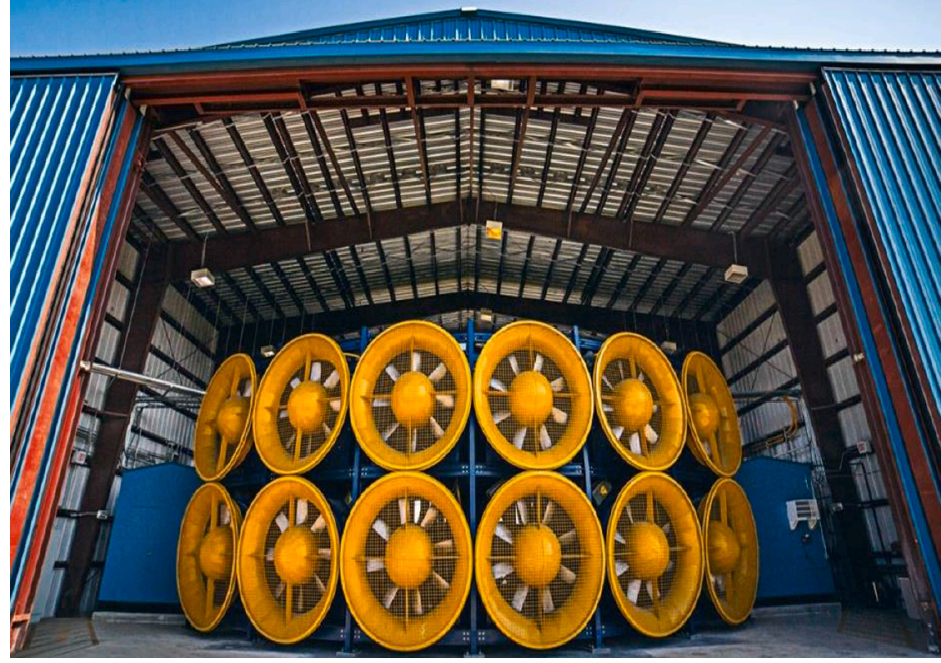
Figure 10. NHERI Wall of Wind Experimental Facility [24].